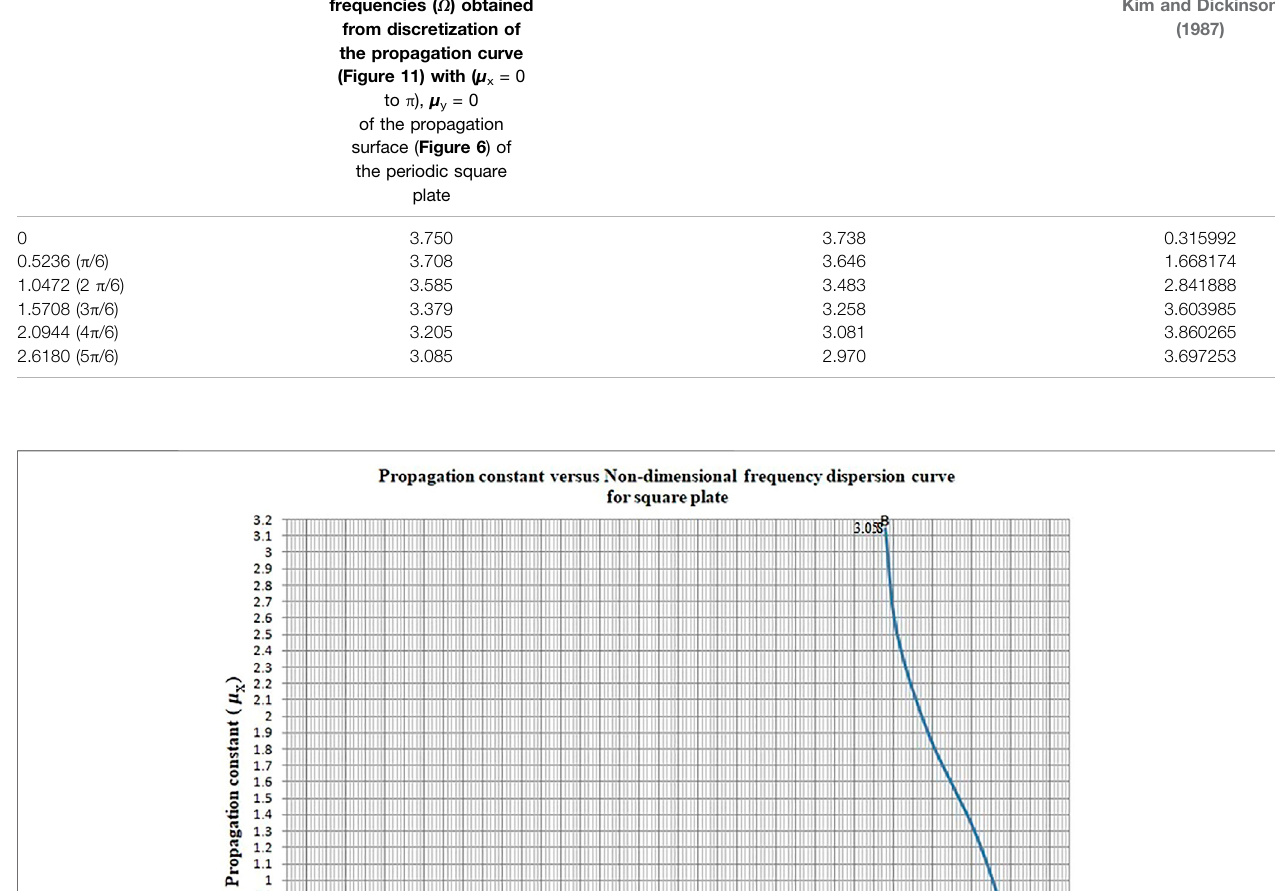
TABLE 4 | Nondimensional frequencies of the 6 × 1 span fi nite periodic plate ( fi xed on four edges) obtained from the propagation surface of the square periodic plate. μ x Present non-dimensional natural